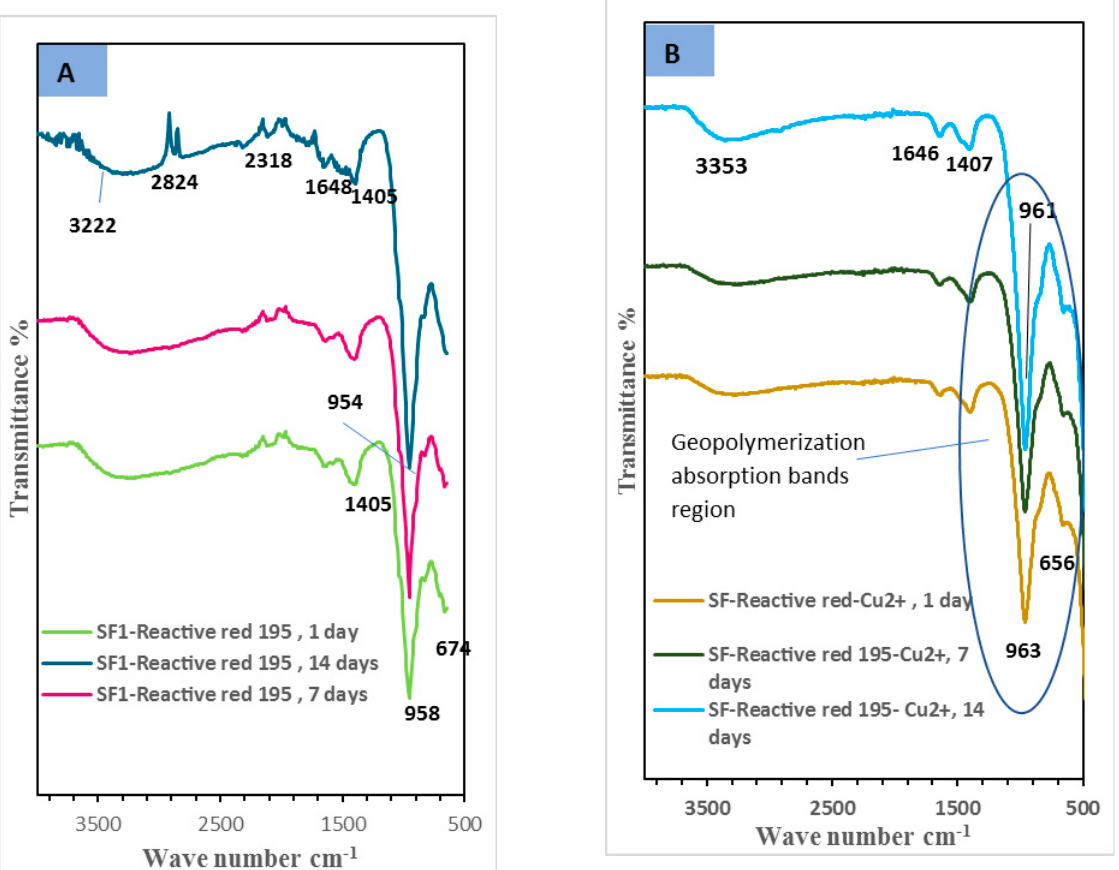
Figure 6. FTIR spectra of different geopolymer mixes cured in water for different hydration ages, ( A ) SF-RD, ( B ) SF-RD-Cu 2+ .